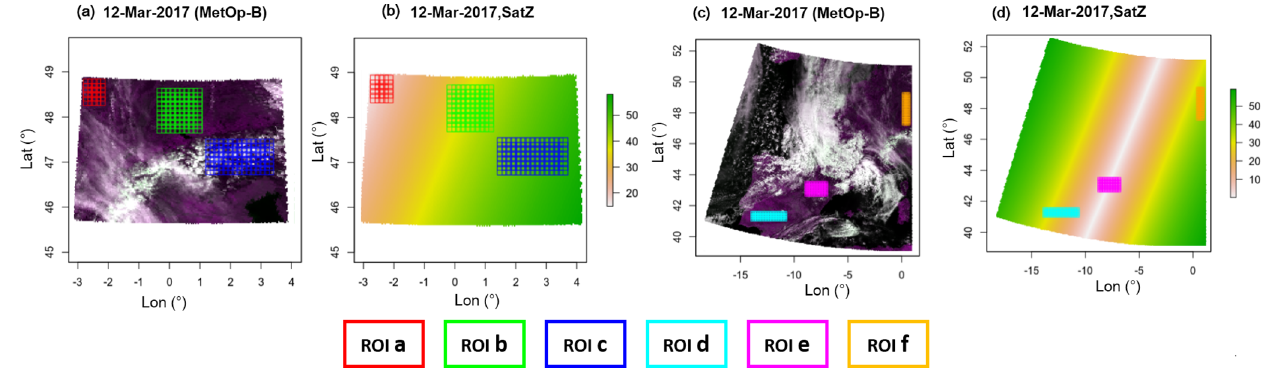
Figure 2. Top-of-atmosphere reflectance true color composite (AVHRR GAC bands 2-1-2) from the MetOp-B satellite on 12 March 2017 (a, c) and the distribution of ROIs (as defined by rectangles with different colors) over the study area. Panels (a) and (c) indicate the two subsets of the dataset corresponding to different areas. Panels (b) and (d) are their corresponding SatZs (indicated by the color bar), respectively. The white line in (d) represents small SatZs along the satellite path. These data are available from the ESA CCI (Climate Change Initiative) cloud project (Stengel et al., 2017).